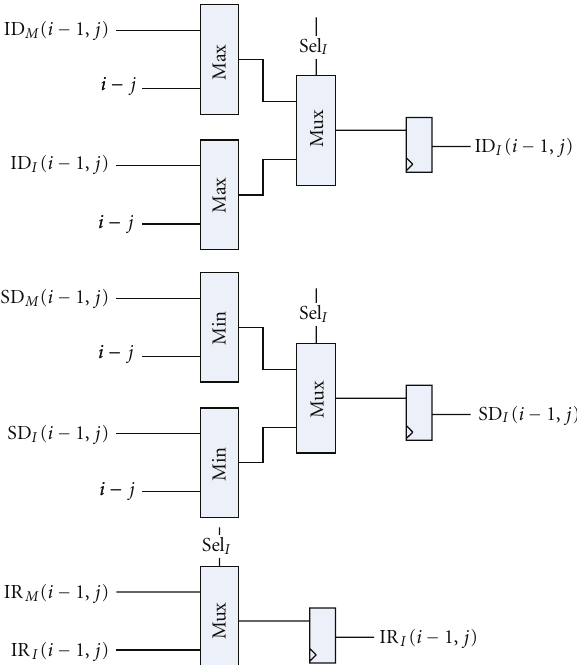
Figure 10: I state divergence calculating